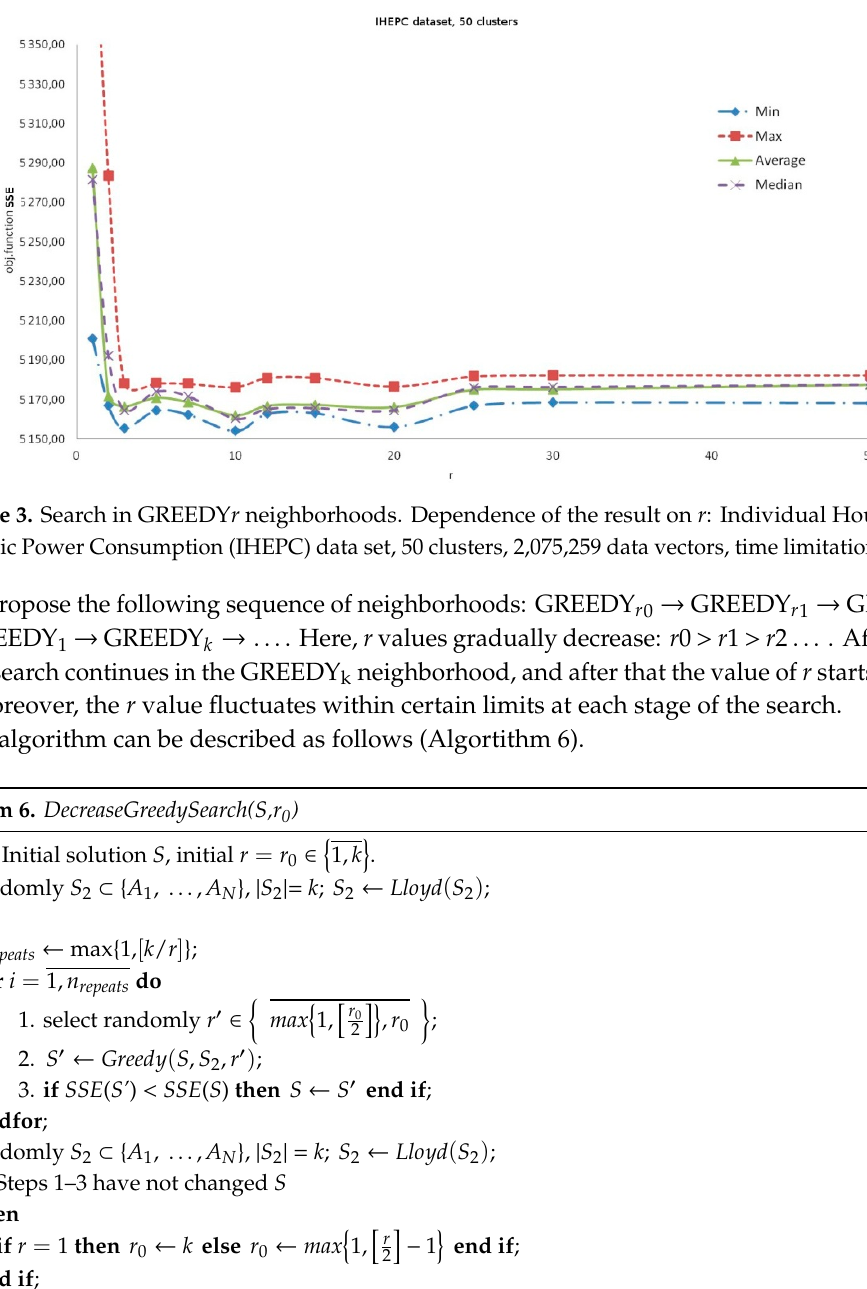
Figure 2. Search in GREEDY r neighborhoods. Dependence of the result on r : ( a ) BIRCH3 data set, 100 clusters, 10 5 data vectors, time limitation 10 s; ( b – d ) Mopsi-Joensuu data set, 30, 100 and 300 clusters, 6014 data vectors, time limitation 5 s; ( e – f ) Mopsi-Finland data set, 100 and 300 clusters, 13,467 data vectors, time limitation 5 s.